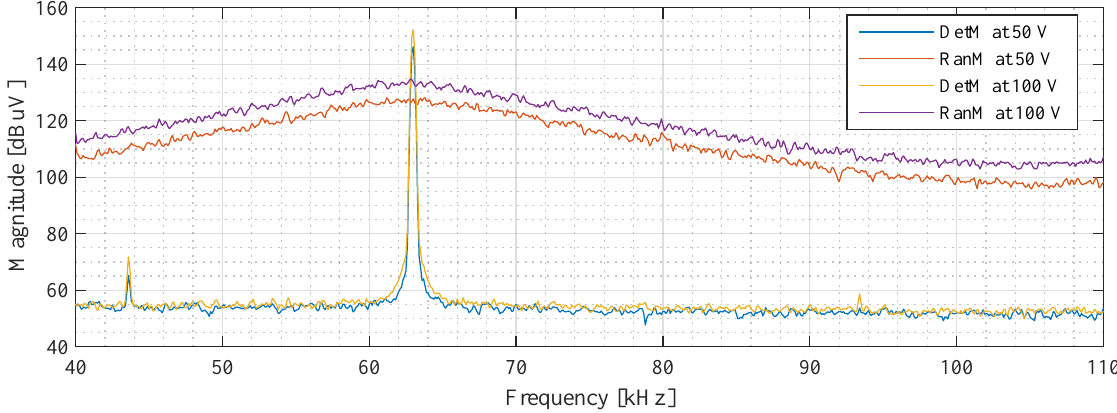
Figure 7. The frequency spectrum of DC/DC converter output at point 2 for DetM and